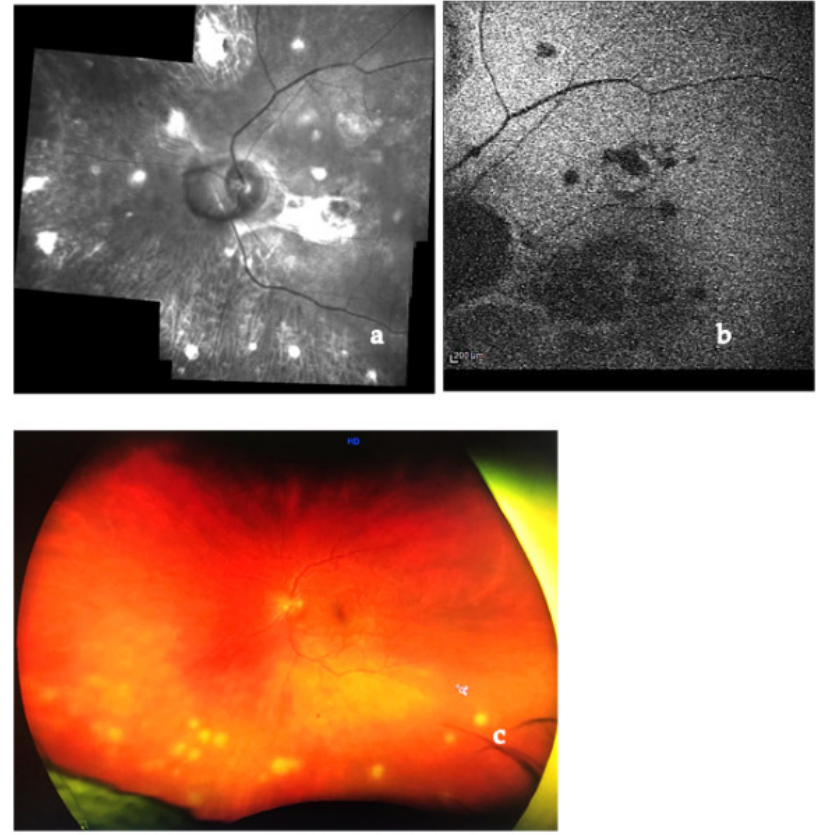
Figure 7. Red-free fundus photography ( a ), BAF ( b ) and UWF ( c ) pictures of a patient affected by retino-choroidal involvement of OS, showing round scattered choroidal granulomas. IR and BAF are useful in S because they show characteristic granulomas and can be used to monitor their evolution in acute or chronic forms over time [157–160].